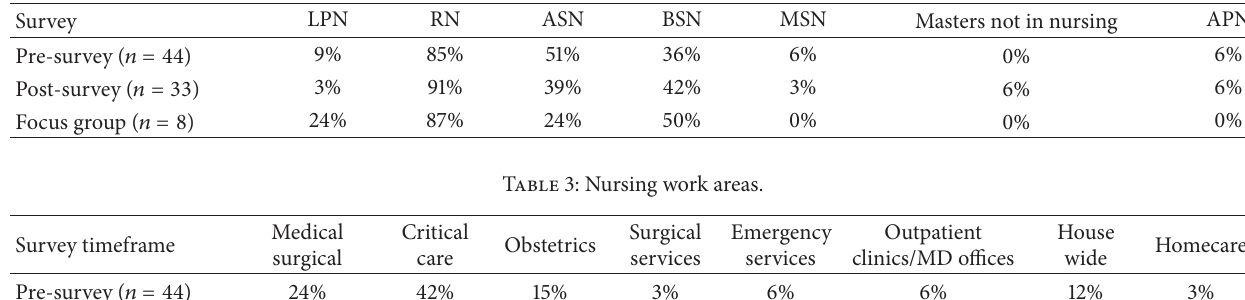
Table 2: Educational preparation.